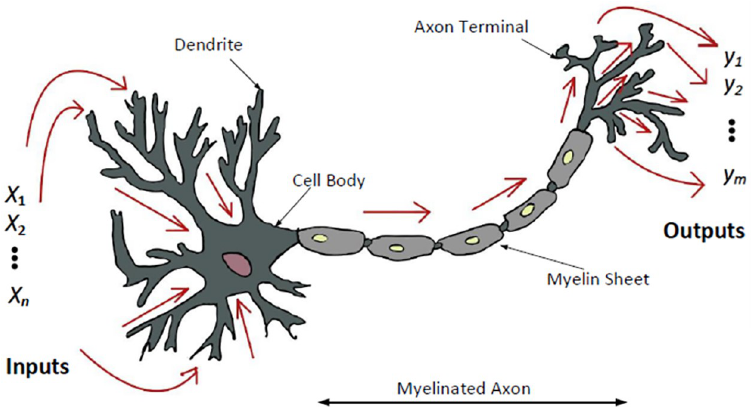
Fig 6. A biological neuron: It accepts multiple inputs x from other perceptrons, and produces a positive output y if the total total evidence is higher the threshold of neurons.